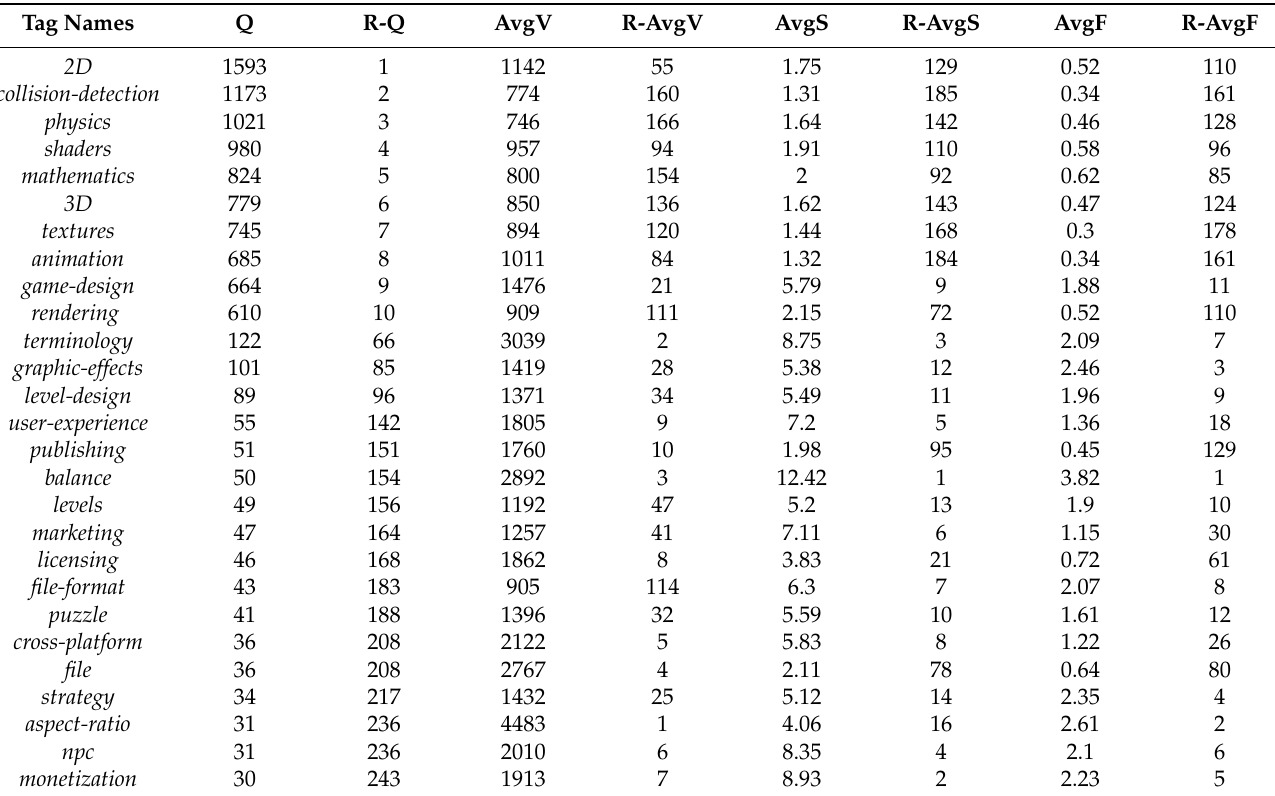
Table 3. Top 10 of all concepts tags for all the considered